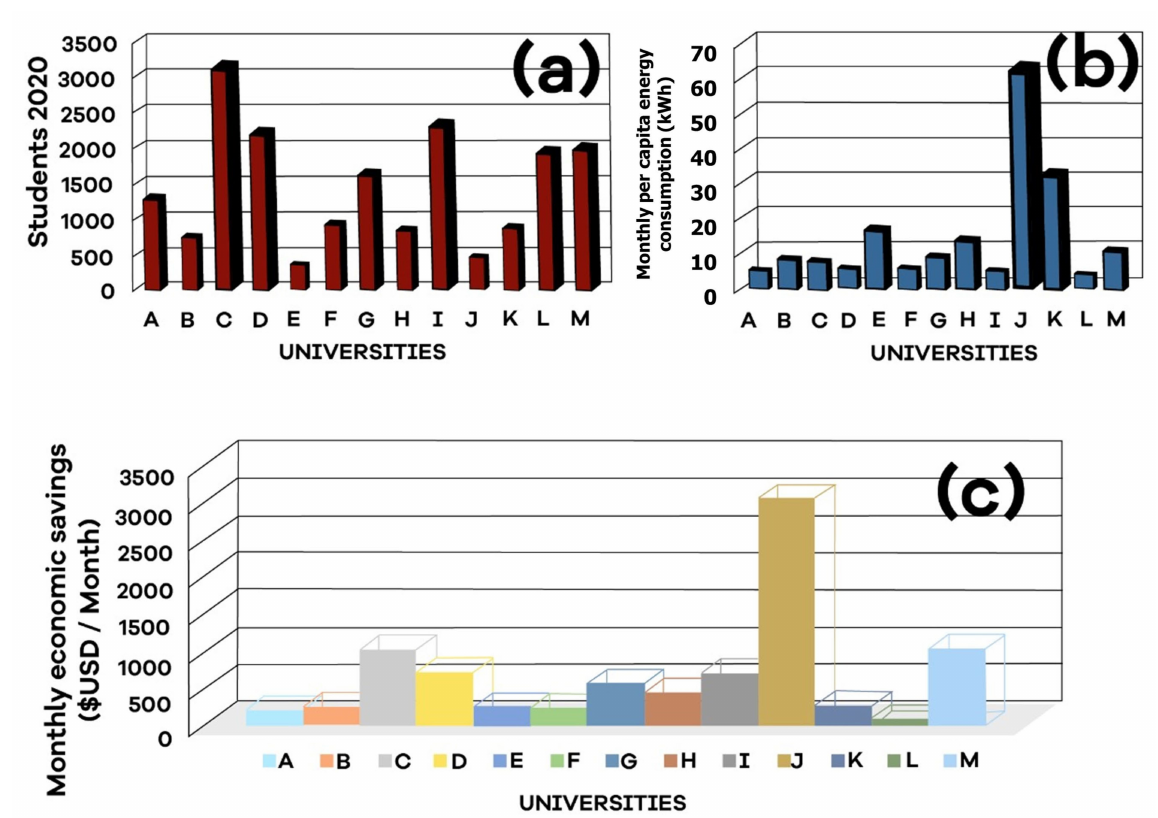
Figure 5. ( a ) Enrollment per university ( b ) Monthly electricity consumption per capita per student for each university ( c ) Monthly energy economic